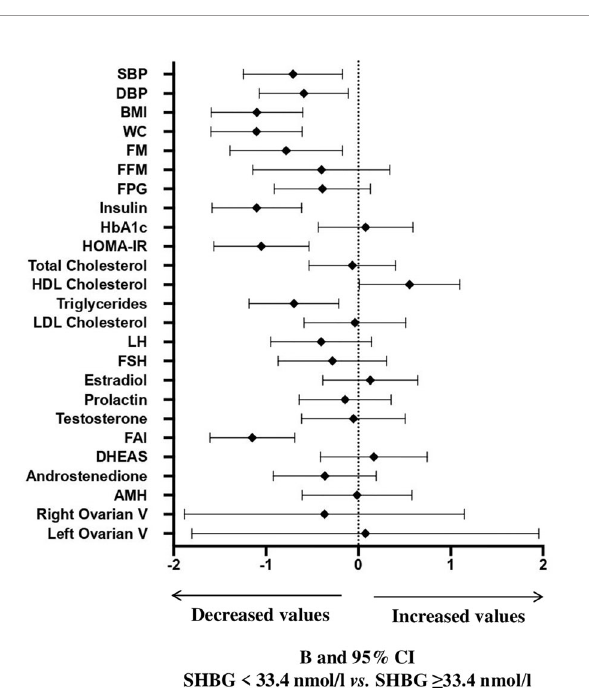
FIGURE 2 | B and 95% con fi dence interval (CI) for several metabolic and hormonal parameters as a function of SHBG <33.4 nmol/L as compared with SHBG ≥ 33.4 nmol/L in Cohort 1. Data are expressed as number of standard deviations from the mean value. The standardized values are based on log- transformed parameters. The statistics based on raw data are reported in Supplementary Table 1 . SBP, systolic blood pressure; DBP, diastolic blood pressure; BMI, body mass index; WC, waist circumference; FM, fat mass; FFM, free fat mass; FPG, fasting blood glucose; HbA1c, glycated hemoglobin; HOMA, Homeostatic Model Assessment for Insulin Resistance; HDL, High- Density Lipoprotein; LDL, low-density lipoprotein; LH, Luteinizing hormone; FSH, Follicle-stimulating hormone; FAI, Free androgen index; DHEAS, Dehydroepiandrosterone sulfate; AMH, Anti-müllerian hormone; V,